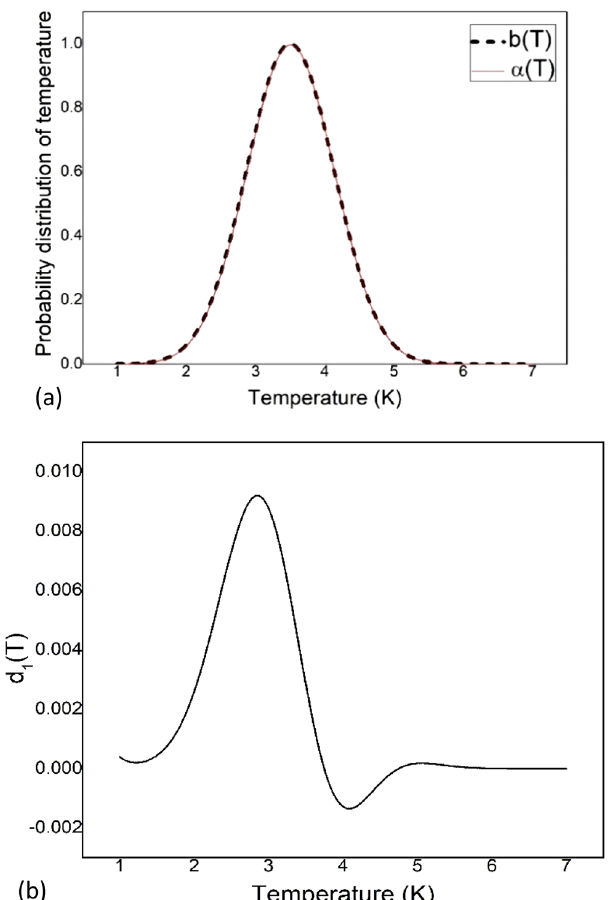
Figure 1. ( a ) Model function b(T) and reconstructed function α (T) are plotted against absolute temperature. 3.5 ) 2 ( T − Here b(T) = e −